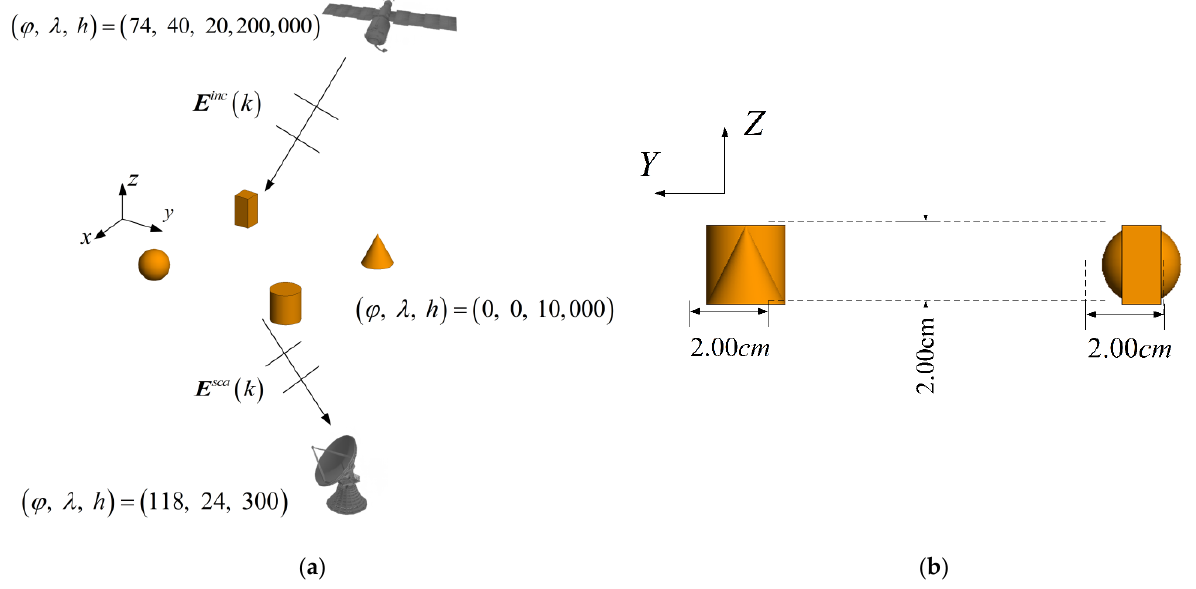
Figure 8. Illustration of the passive bistatic radar system based on non-cooperative satellite-borne illuminator. ( a ) Geometry of the discrete objects. ( b ) The model size of the discrete